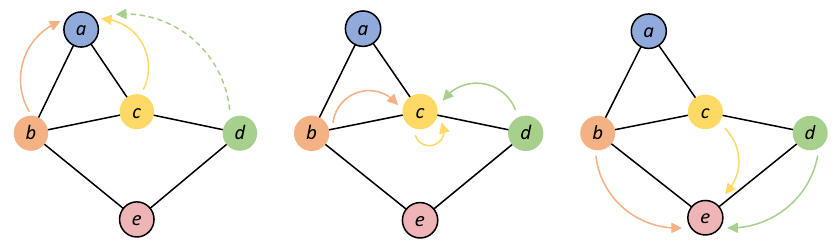
Figure 4. A batch convolution operation of node a, c, e in FastGCN with sampling node b, c,